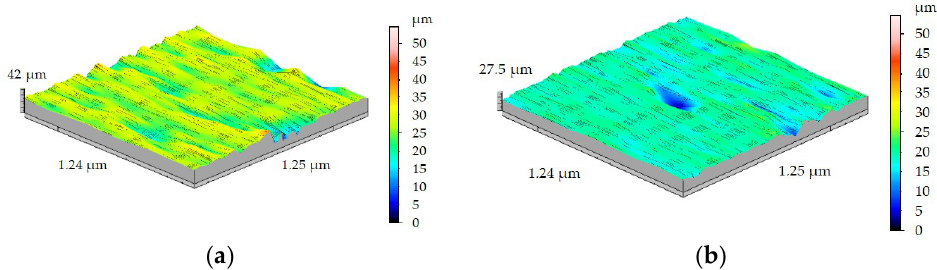
Figure 15. Results of 3D surface measurement samples after turning with f = 0.125 mm/rev of: ( a ) FEPA 046, ( b ) FEPA 100.